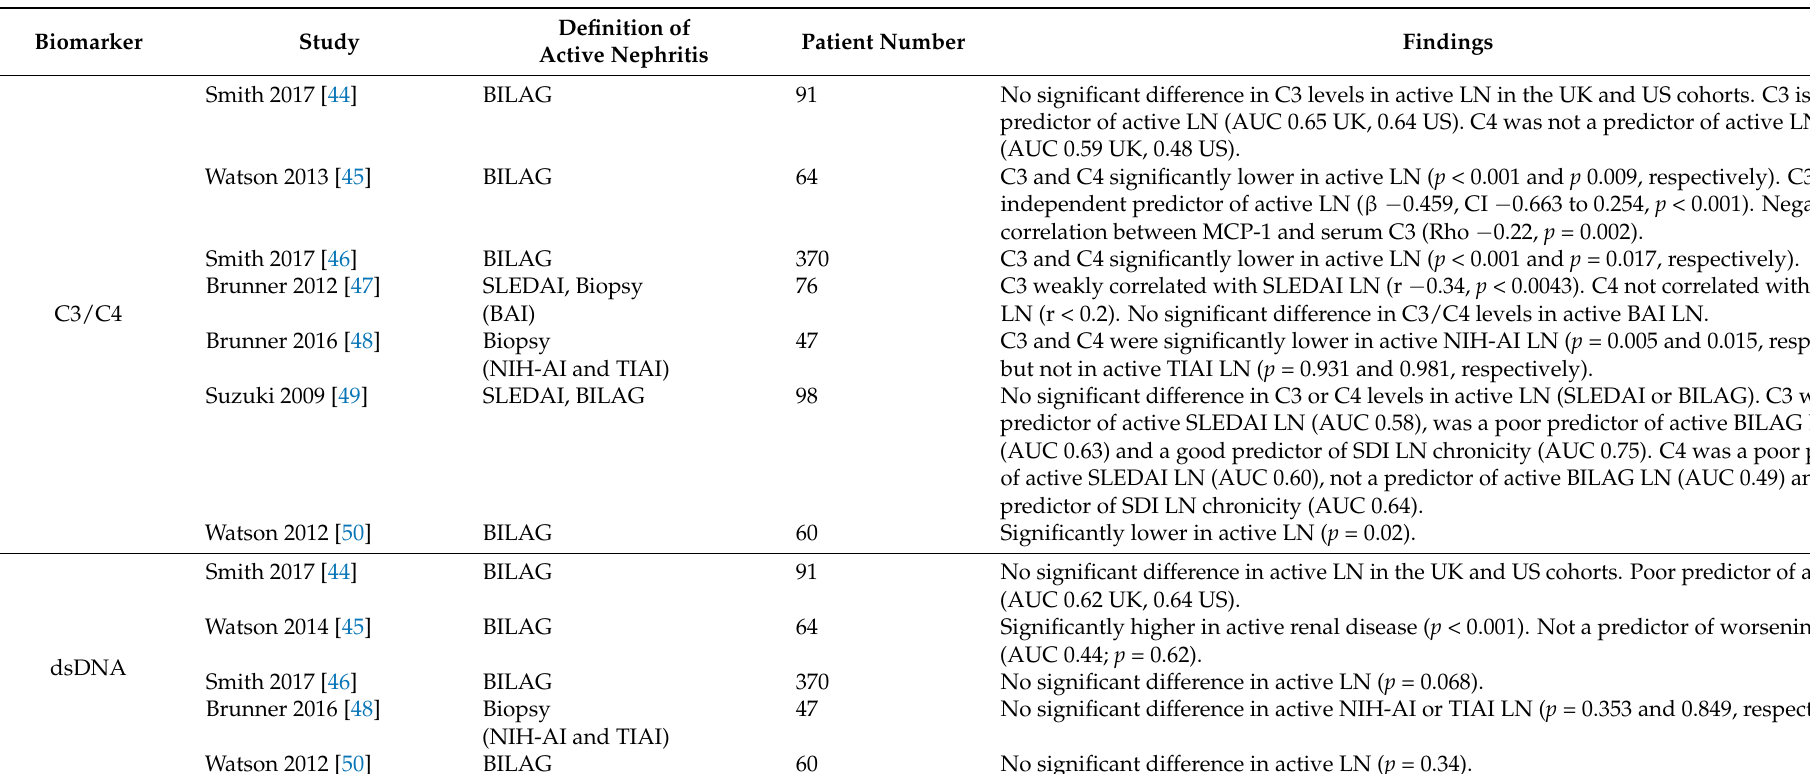
Table 1. Classical renal